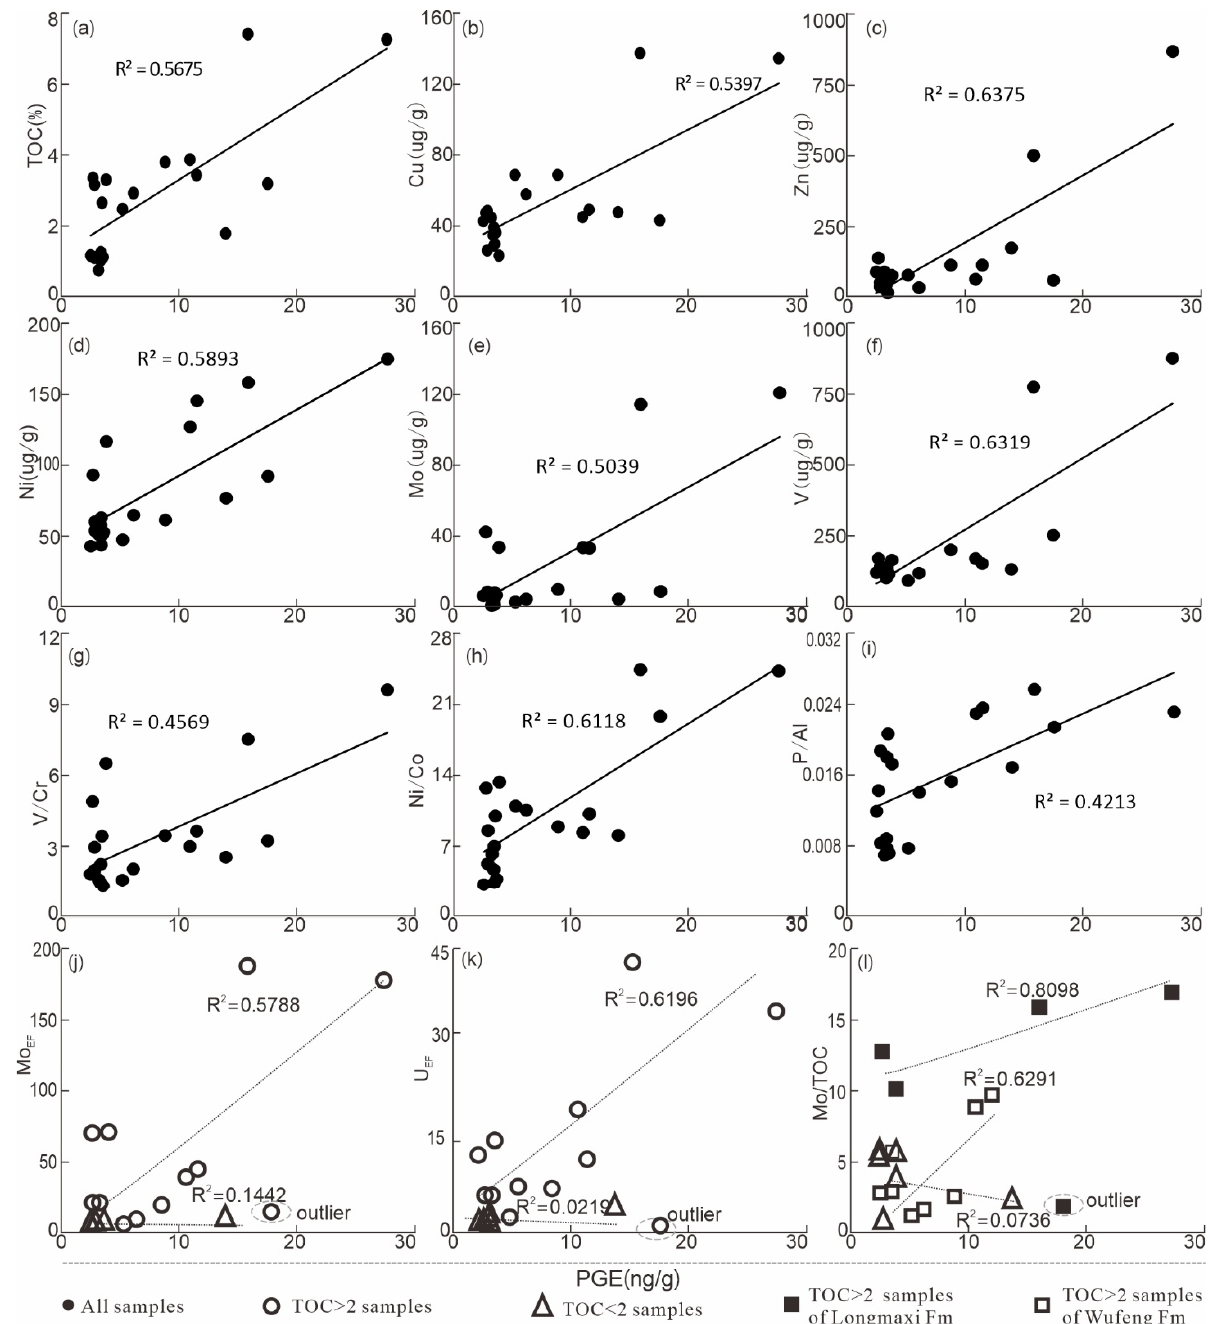
Figure 11. Linear relationship between PGE with elements and parameters. ( a ) PGE-TOC linear relationship diagram; ( b ) PGE-Cu linear relationship diagram; ( c ) PGE-Zn linear relationship diagram; ( d ) PGE-Ni linear relationship diagram; ( e ) PGE-Mo linear relationship diagram; ( f ) PGE-V linear relationship diagram; ( g ) PGE-V/Cr linear relationship diagram; ( h ) PGE-Ni/Co linear relationship diagram; ( i ) PGE-P/Al linear relationship diagram; ( j ) PGE-Mo EF linear relationship diagram; ( k ) PGE-U EF linear relationship diagram; ( l ) PGE-Mo/TOC linear relationship diagram.